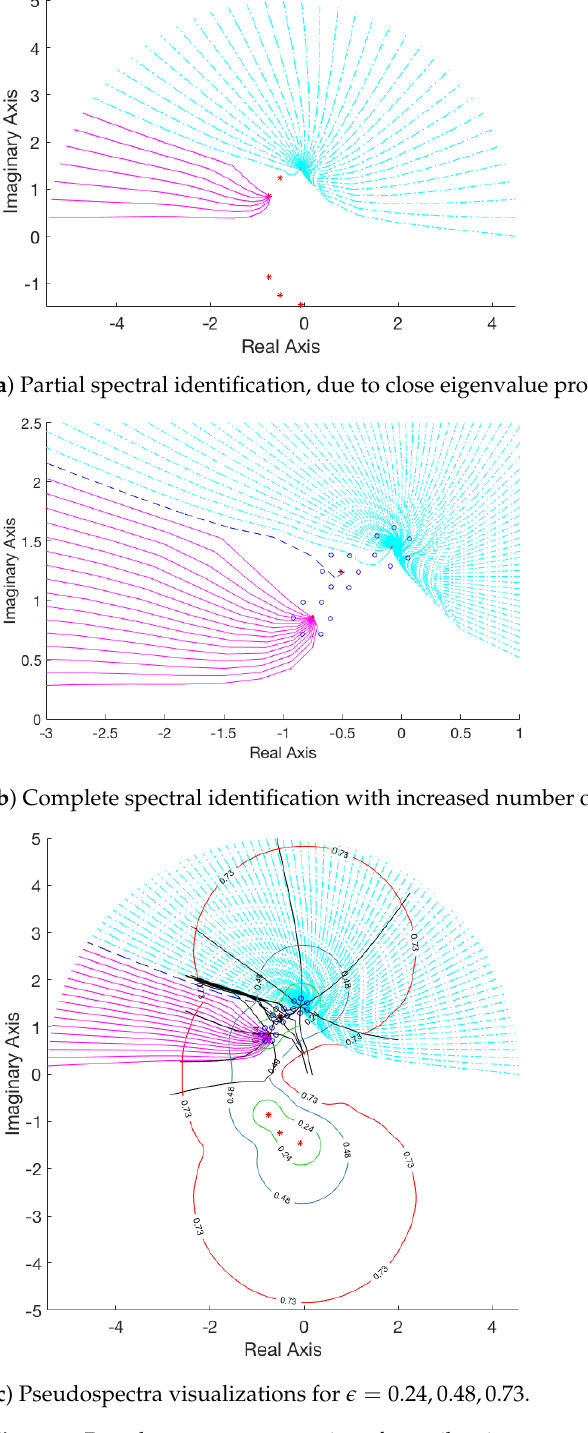
Figure 6. Pseudospectra computations for a vibrating